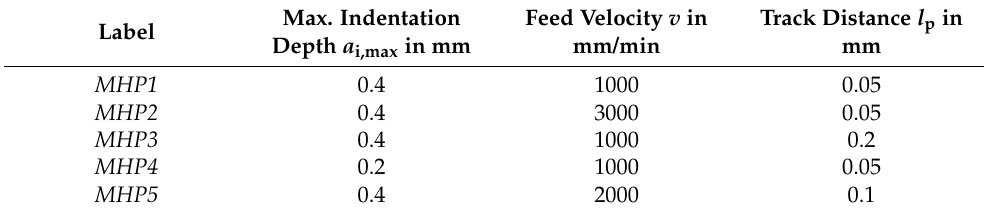
Table 3. Process parameter values for the MHP